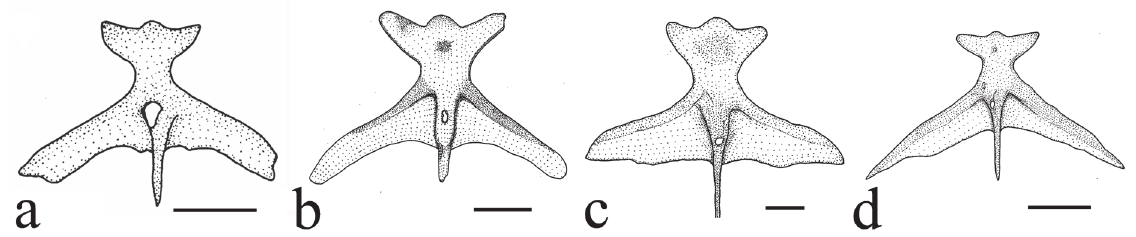
Fig. 5. Dorsal view of urohyal of ( a ) Trichomycterus balios , paratype, UFRGS 6831, 81.7 mm SL; ( b ) T . diatropoporos , paratype, UFRGS 16237, 57.8 mm SL; ( c ) T . poikilos , paratype, MCP 22699, 79.0 mm SL; and ( d ) T . brachykechenos , paratype, UFRGS 16245, 41.9 mm SL. Scale bar = 0.5